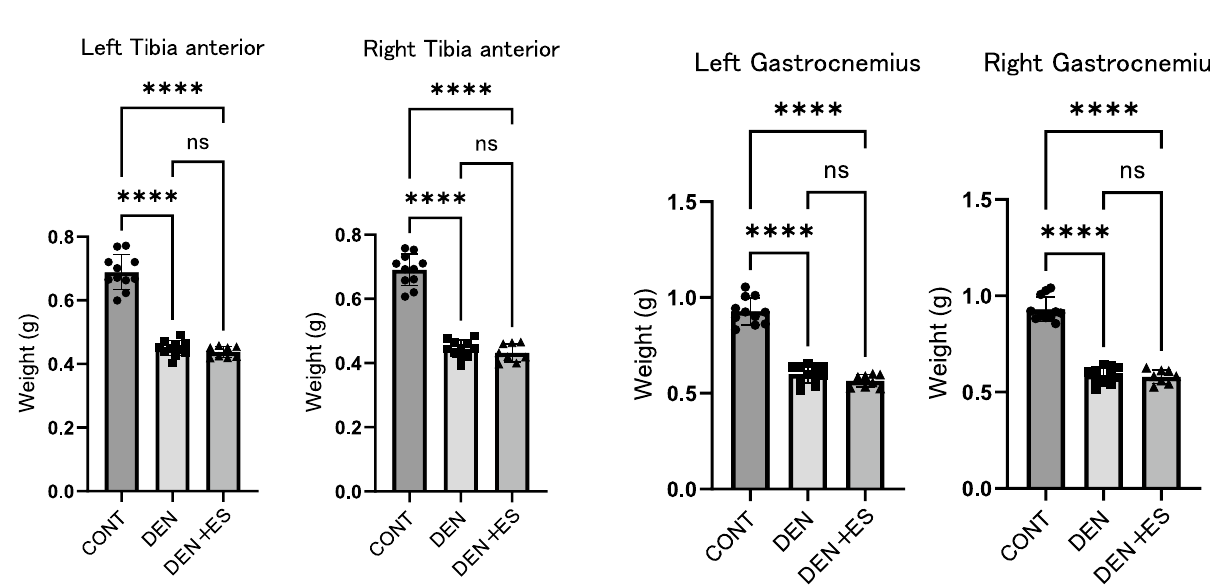
Figure 6. Muscle wet weight of left and right TA, GAS after pad electrode chronic stimulation. Mean ± SD. One-way ANOVA test was used to evaluate changes in the wet weight of the lower limb muscles 24 h after chronic stimulation with pad electrodes. CONT unstimulated control group, DEN denervation muscle atrophy induced group, DEN + ES denervation muscle atrophy induced + belt electrode electrical stimulation group; ****p <